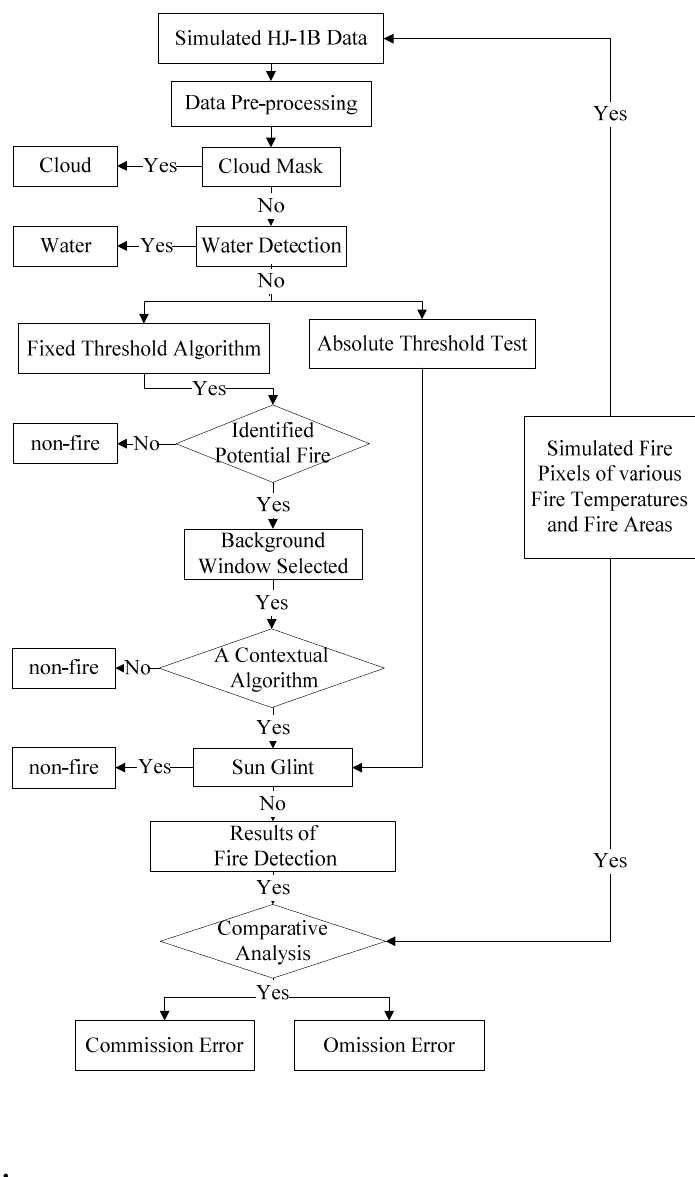
Figure 4. The flow chart of fire